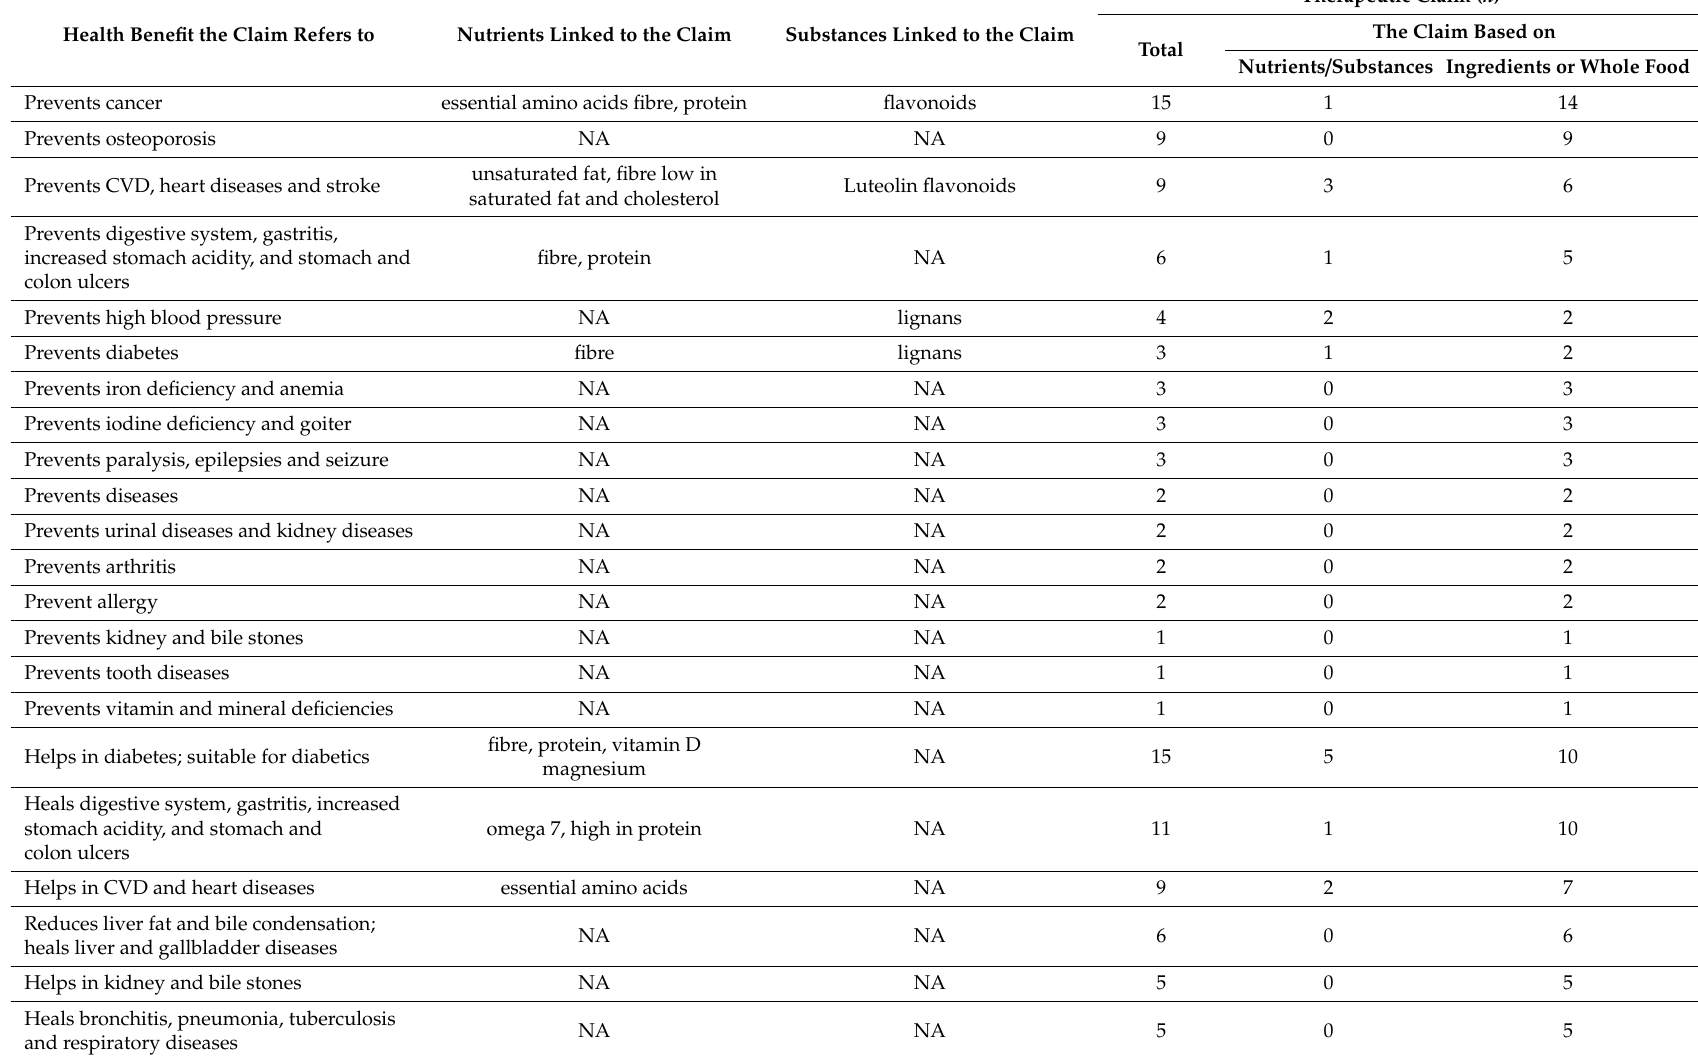
Table A4. Therapeutic claims by attributable health